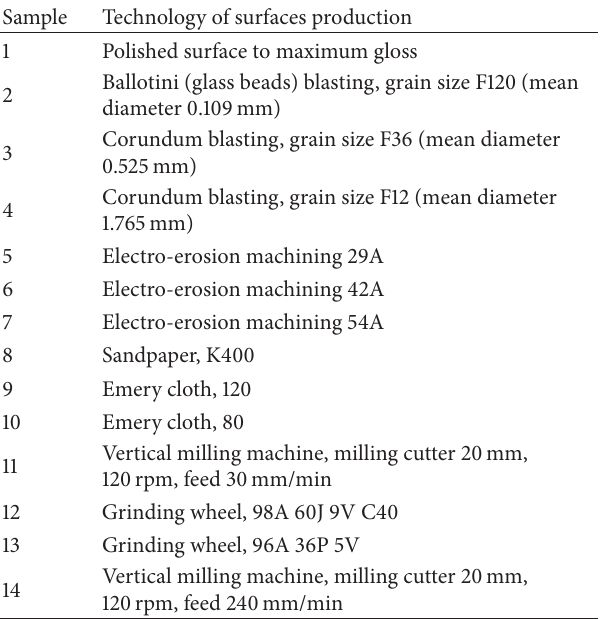
Table 1: List of analysed samples with their production properties.